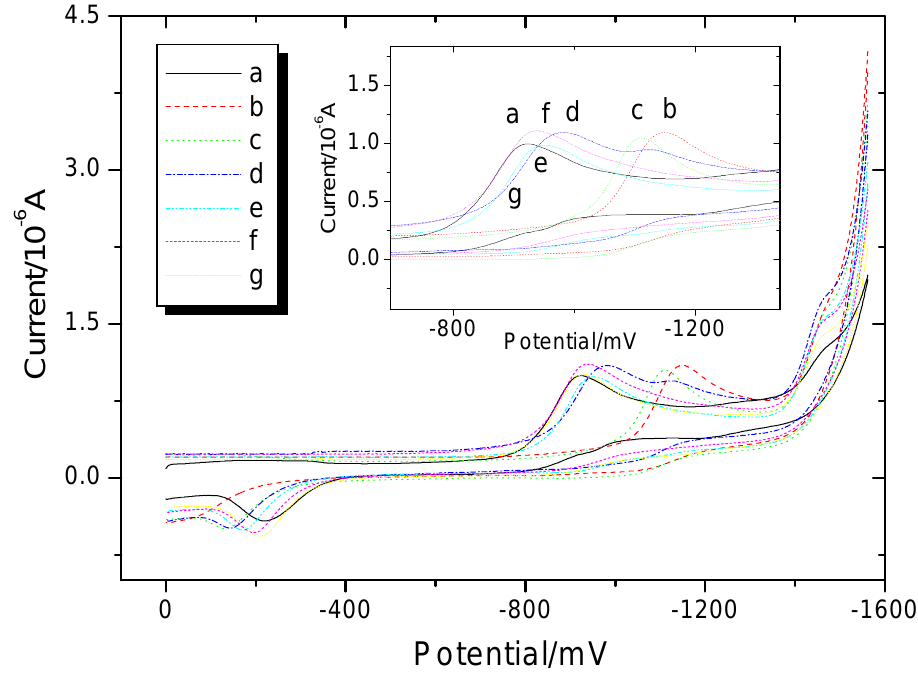
Figure 4. The cyclic voltammogram of NAD + , GDH-NAD + and Al-GDH-NAD + ; in 0.1M pH=6.5 Tris-HCl buffer solution; 0.1mM NAD + +20 µ L GDH; Al: NAD + : a, 0:1 (no GDH); b, 0:1 (GDH); c, 1/4:1 (GDH); d, 1/2:1 (GDH); e, 1:1 (GDH); f, 2:1 (GDH); g, 4:1 (GDH) on a three-electrode system